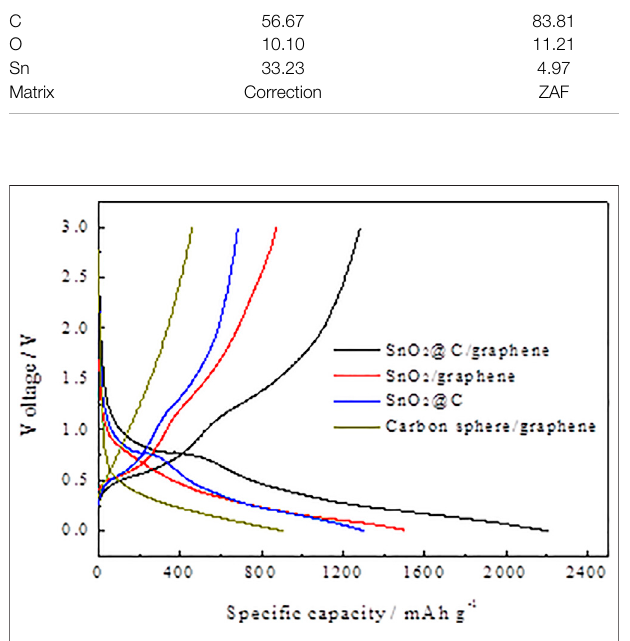
FIGURE 6 | First charge – discharge pro fi les of carbon spheres/ graphene, SnO 2 /graphene, SnO 2 @C, and SnO 2 @C/graphene.